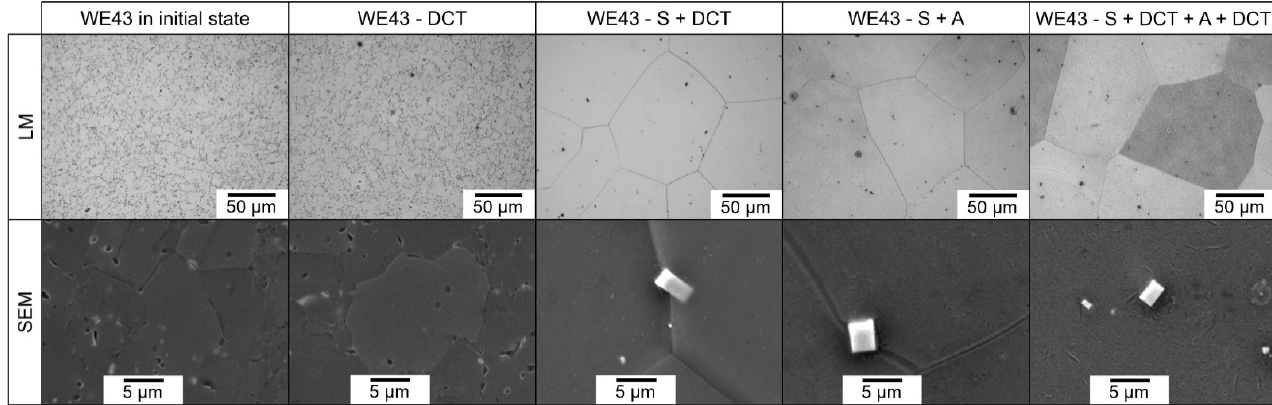
Figure 4. Hardness H IT ( a ) and Young’s modulus E IT ( b ) of WE43 magnesium alloy as a function of max- imum indenter load F max . The error bars in the figures represent a standard deviation (σ HIT = 9.97– 38 .26 MPa; σ EIT = 0.36–3. 58 GPa) . ( σ σ HIT = 9.97–38.26 MPa; EIT = 0.36–3.58 GPa).